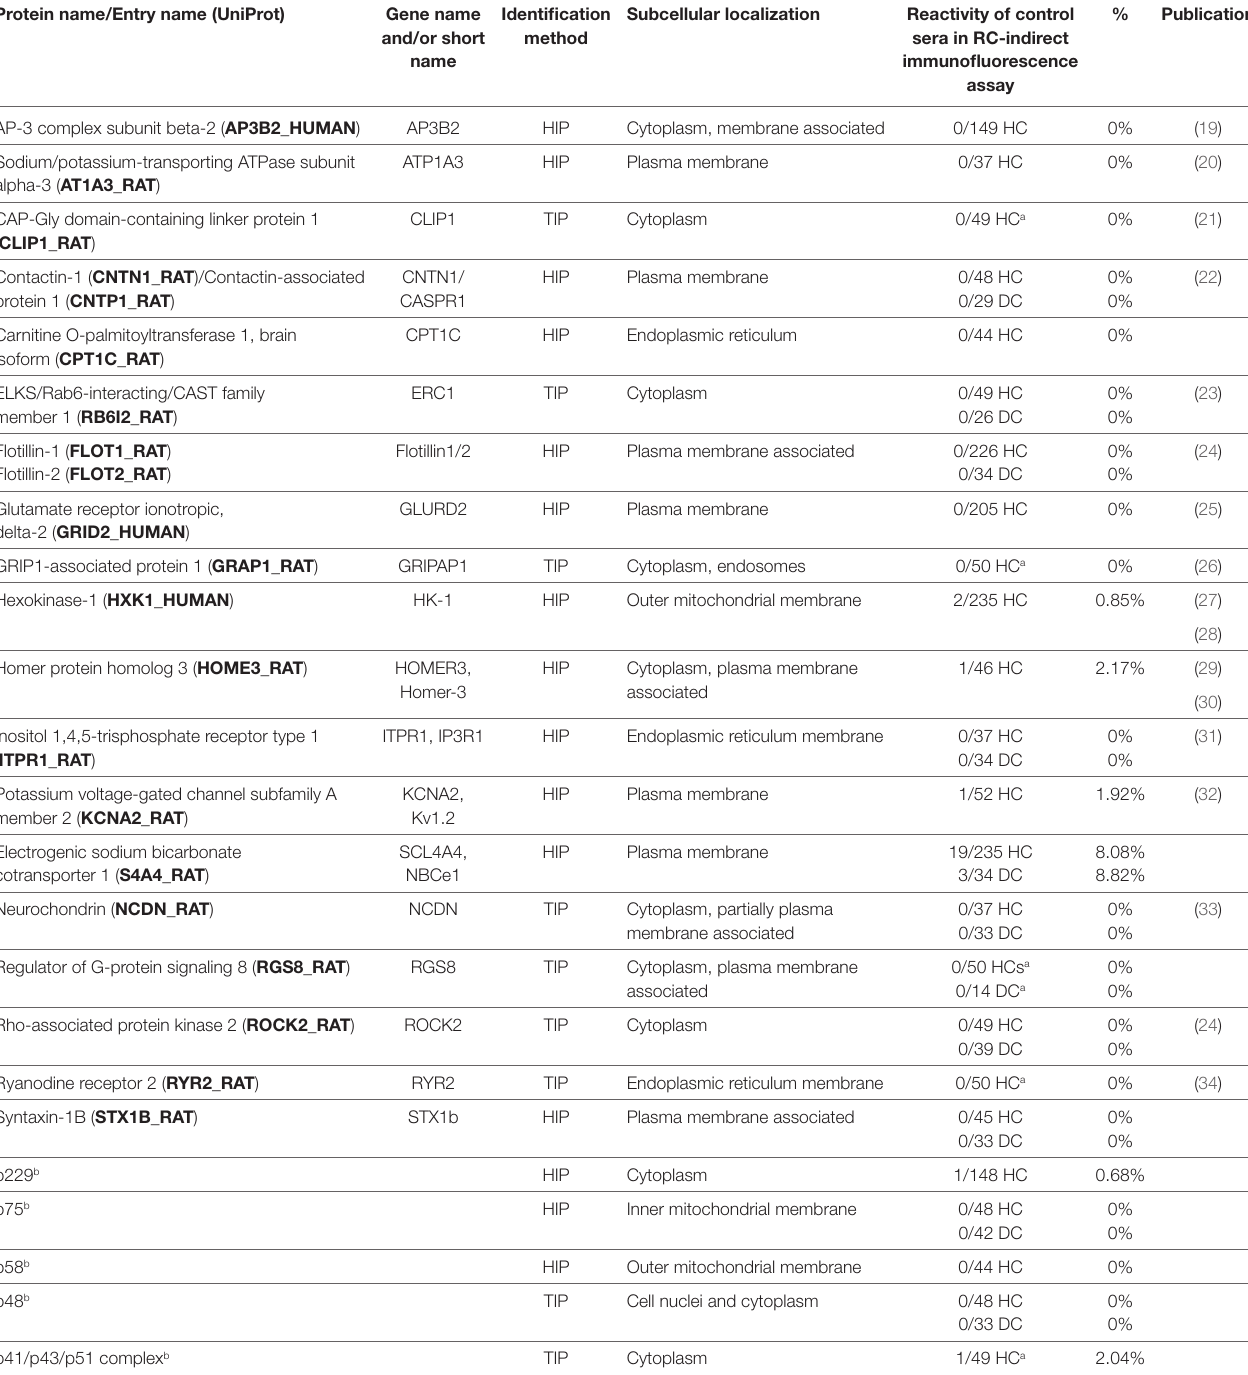
TaBle 2 | Antigens identified using histo-immunoprecipitation (HIP) or tissue-immunoprecipitation